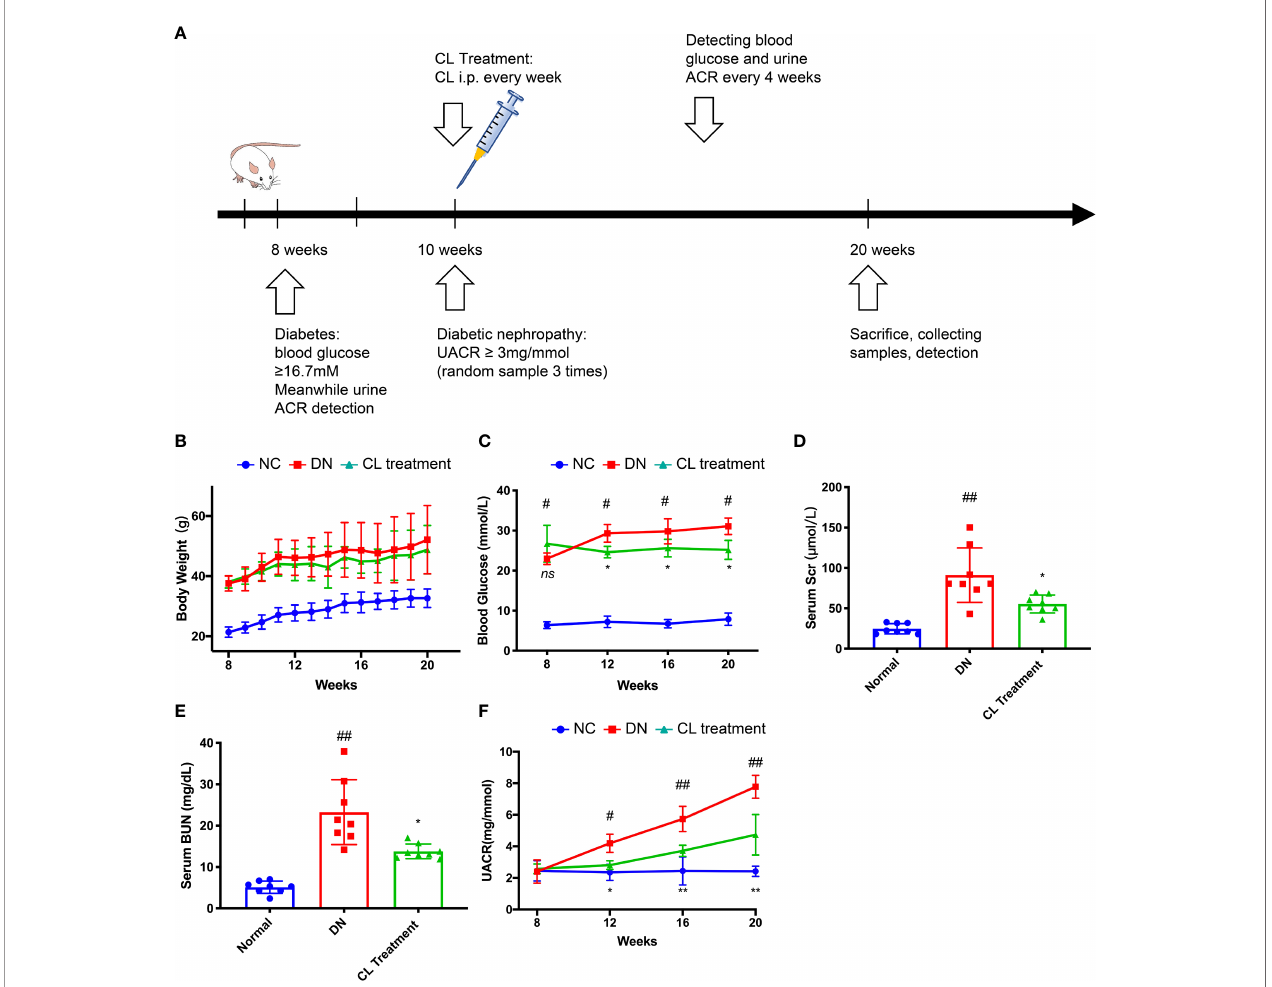
FIGURE 2 | Macrophage depletion alleviates blood glucose, improves kidney function and relieves albuminuria in diabetic mice. (A) Schematic of the mouse experimental protocol. (B) Body weight of the mice. (C) Blood glucose levels of the mice. (D) Serum creatinine levels of the mice. (E) Blood urea nitrogen (BUN) levels of the mice. (F) Urine albumin-creatinine ratios of the mice. NC, normal control group (db/m); DN, DN group (db/db); CL, CL treatment (db/db+CL treatment). # p < 0.05 vs . the normal group (db/m), ## p < 0.01 vs. the normal group (db/m), *p < 0.05 vs. the DN group (db/db), **p < 0.01 vs. the DN group (db/db) ns, no signi fi